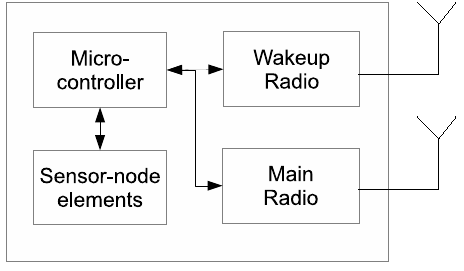
Figure 1. Common architecture of a sensor node with